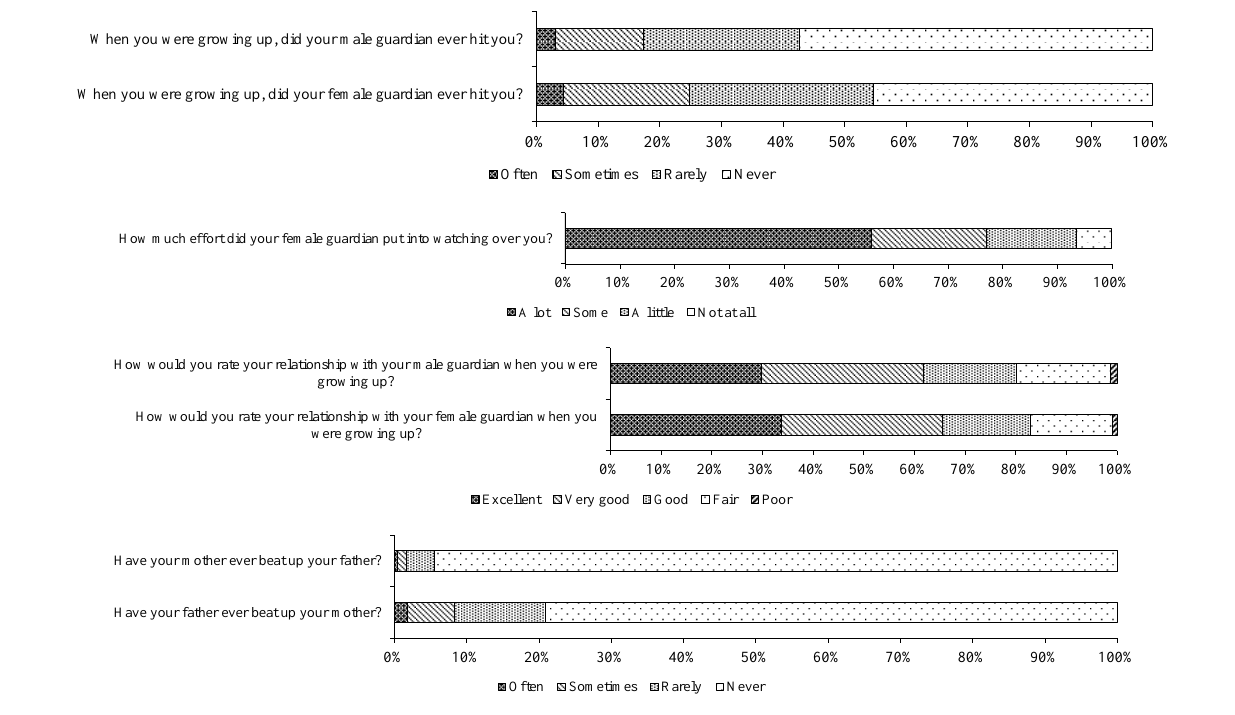
Figure 1. Descriptive statistics of domestic violence dimensions. Table 1. Domestic violence dimensions and quantitative methods.